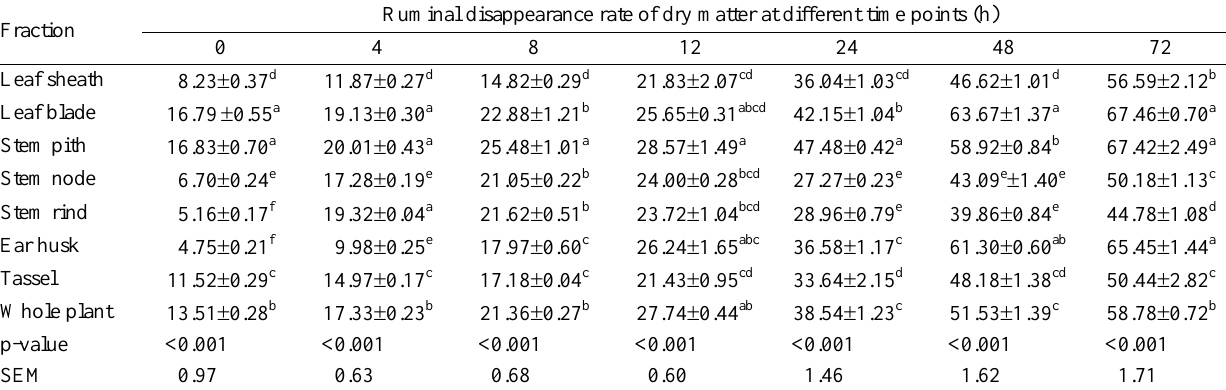
Table 2. Ruminal disappearance rate (%) of DM from whole corn stover and different morphological fractions Ruminal disappearance rate of dry matter at different time points (h) Fraction